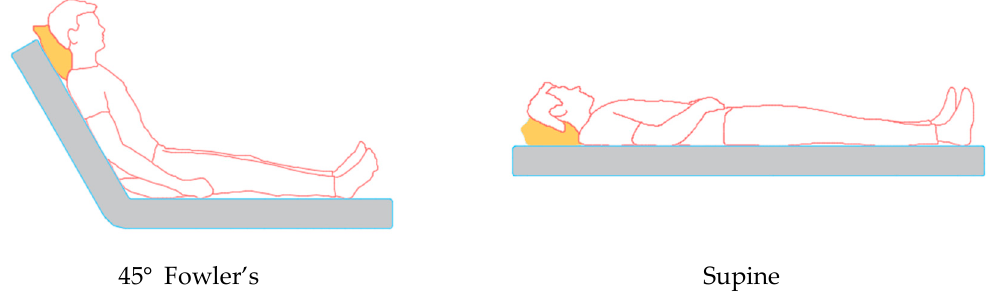
Figure 3. The RR measurement at different body postures.